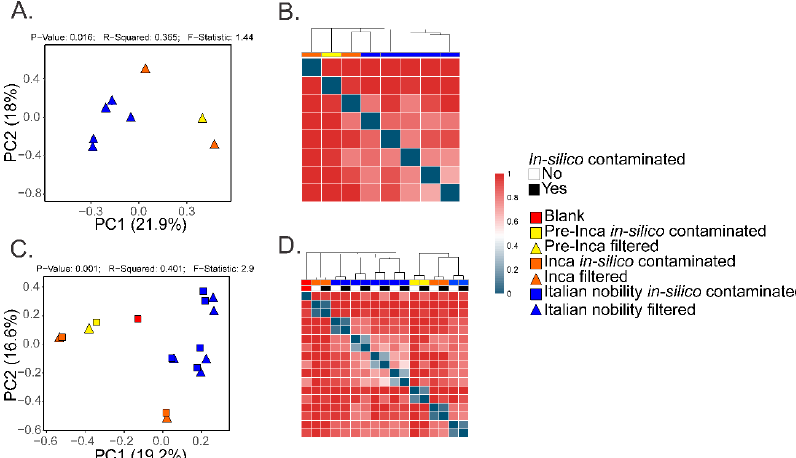
Figure 2. Beta diversity of the mummified gut remains. Results show the beta-diversity (Bray Curtis index) visualized as Principal Coordinate Analyses (PCoA) ( A ) and hierarchical cluster plots ( B ). Values were calculated after filtering OTUs present in the blank control from the mummified microbiome (see text). Results also show the beta-diversity (Bray-Curtis index) of the in-silico contaminated samples (see text) compared to the filtered samples. Results were visualized as PCoA plots ( C ) and hierarchical cluster plots ( D ).